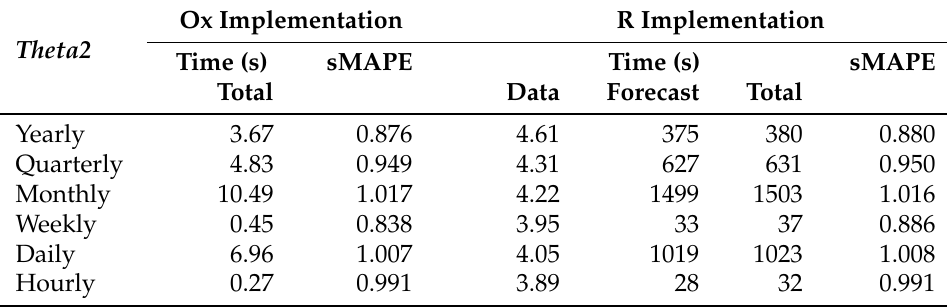
Table A3. Timings to compute Theta2 forecasts, comparing R and Ox